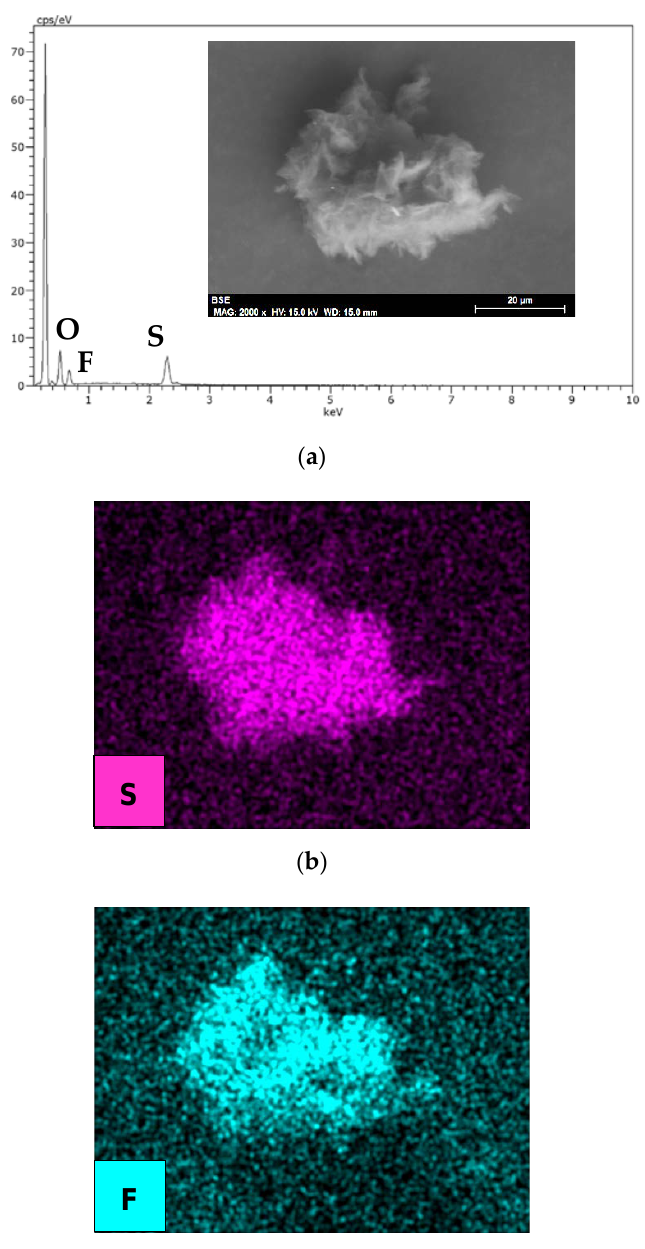
Figure 11. ( a ) SEM micrograph and EDX spectrum of wear debris after lubrication with IL+G, and element maps for ( b ) sulfur and ( c ) fluorine.